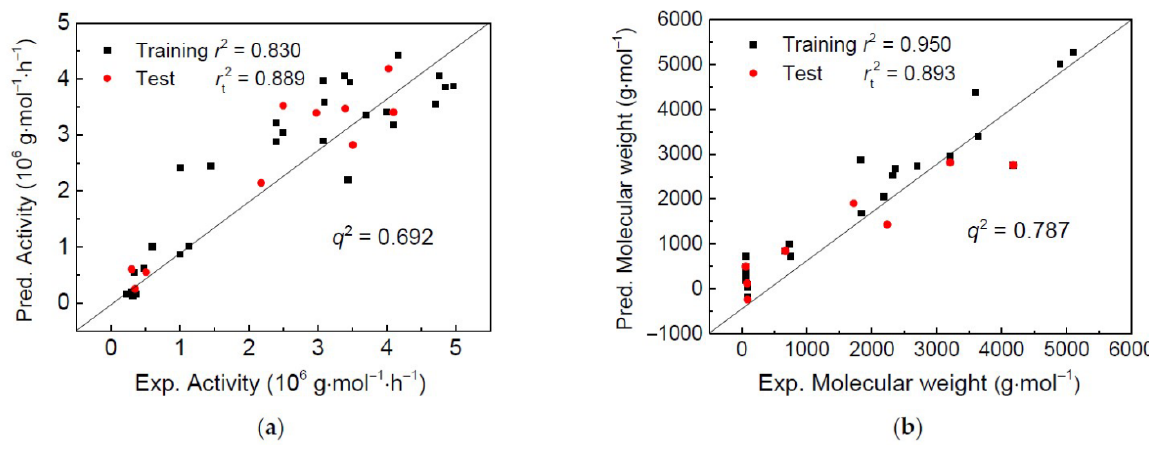
Figure 3. Experimental catalytic activities ( a ) and molecular weight ( b ) versus the predicted values by 3D-QSPR model for the training set and test set.